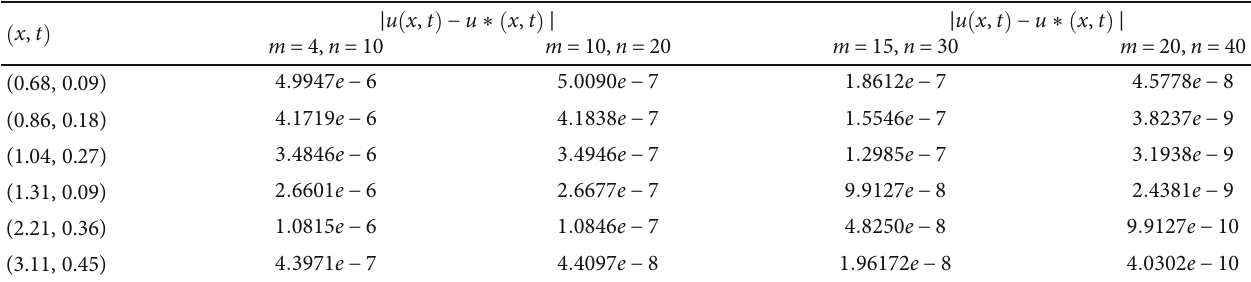
Figure 1: Portrait of the numerical solution and the absolute error for Example 6 with m = 4, n = 10 . Table 1: Absolute error for di ff erent values of m , n for Example 6.